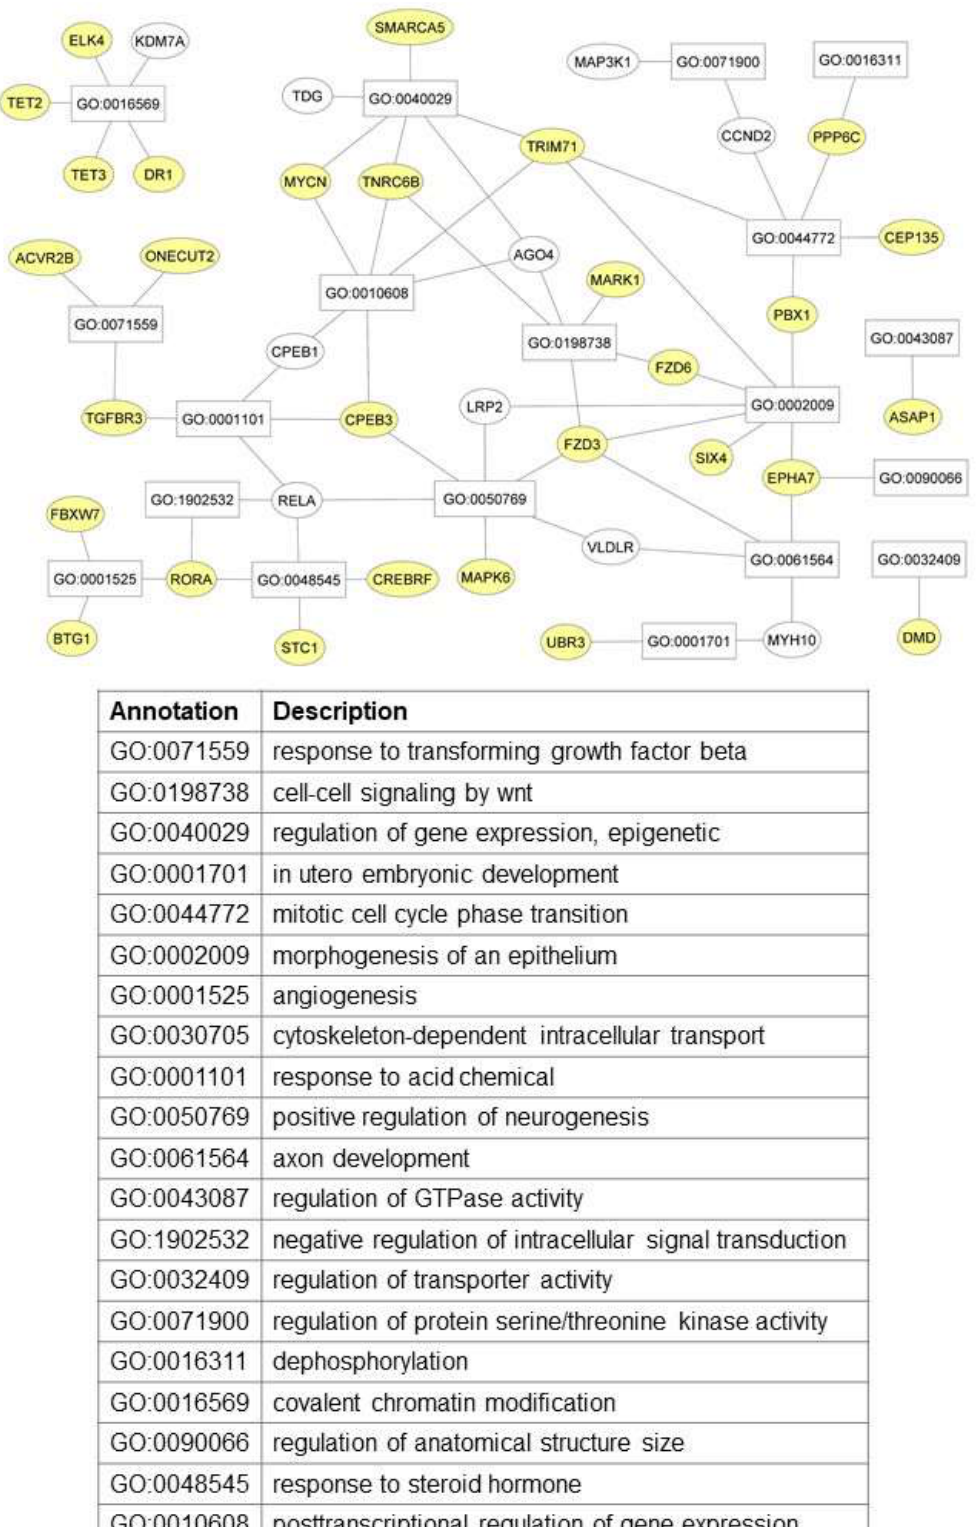
Figure 6. The network describing the relationships between the genes targeted by more than one miRNA and the gene ontology (GO) associated with biological processes. The analysis was performed using the tool Cytoscape_v3.9.0. The network is reported at the top (the validated targets are shown in yellow), while the GO annotations are shown at the bottom.